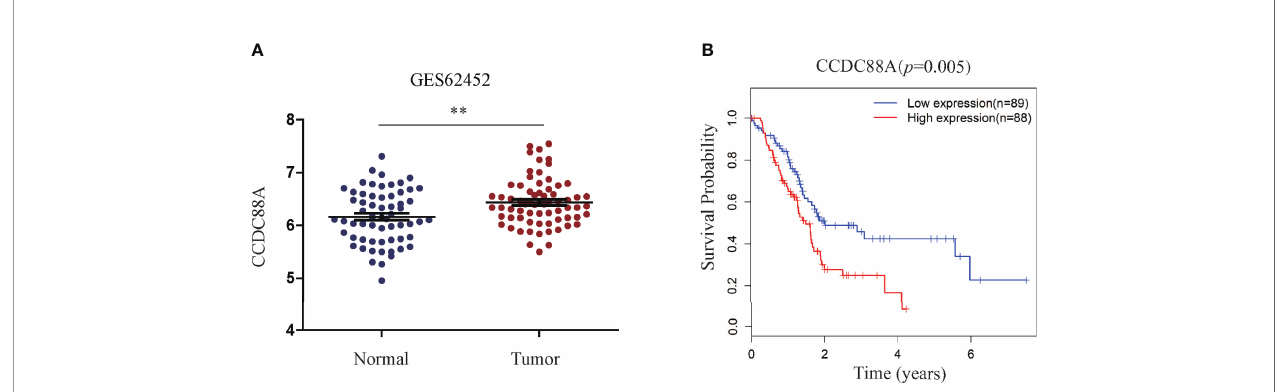
FIGURE 1 | Statistical analysis of the correlation between Girdin expression and pancreatic cancer through databases. (A) Girdin expression level in PC tissue was signi fi cantly higher than that seen in the Normal tissue, data from GEO database, numbered GES62452. (B) Overall survival (OS) was compared between patients with low and high expression Girdin, data from TCGA database. **P <